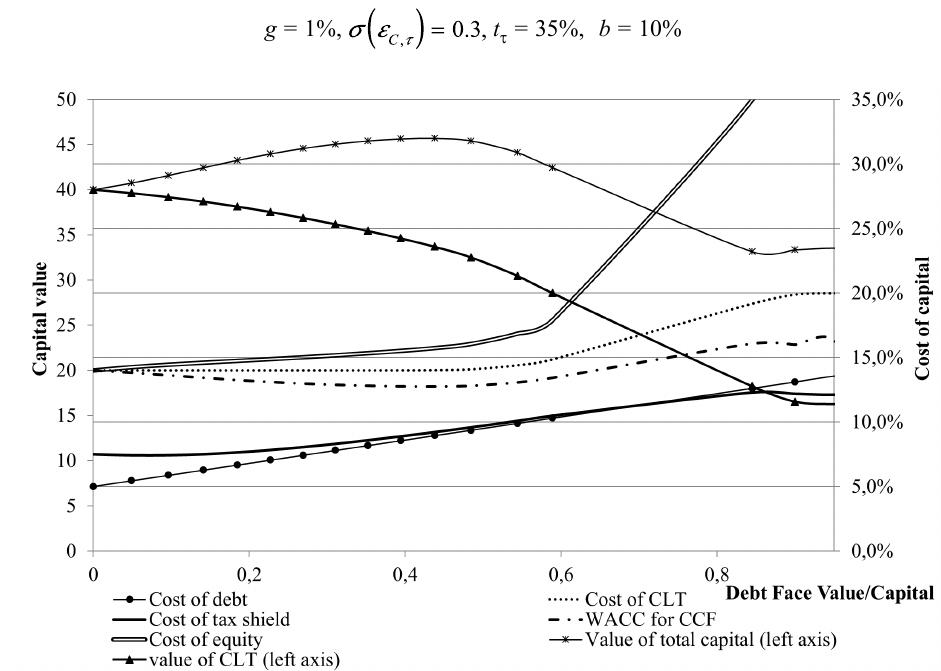
Fig. 3. High-growth-high-risk companies with high CFD g = 4%, t t = 35%, b =